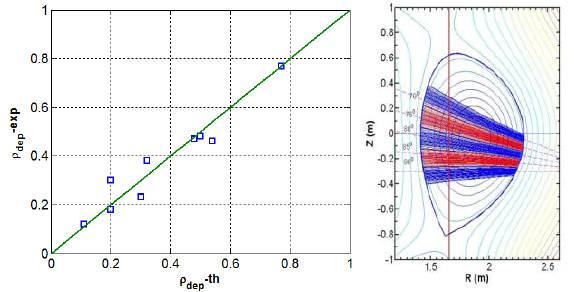
Fig.12. Measured Versus Calculated Deposition Radius by 10Hz/1s modulated ECRH